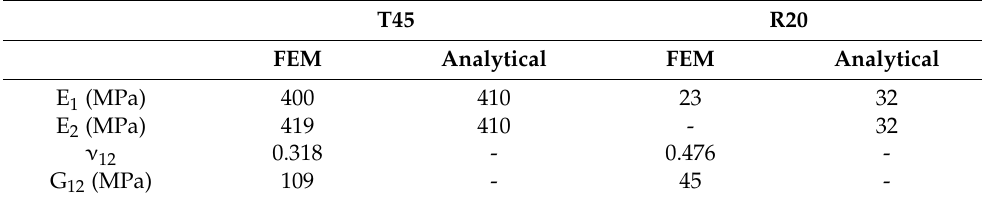
Table 6. Results of the explicit homogenisation procedure.